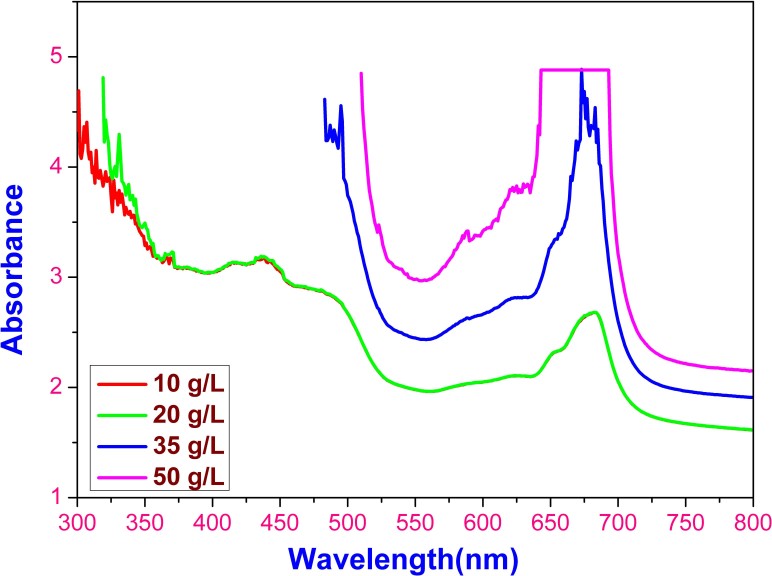
At various concentrations of microalgae samples, the absorbance and the wavelength are plotted and is found that the maximum absorbance occurs at 680 nm wavelength.